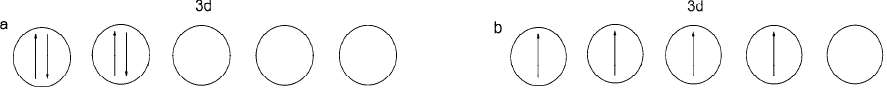
Figure 6. Valence electron diagrams of Cr atom in ( a ) bulk and ( b ) monolayer CrSi 2 systems.